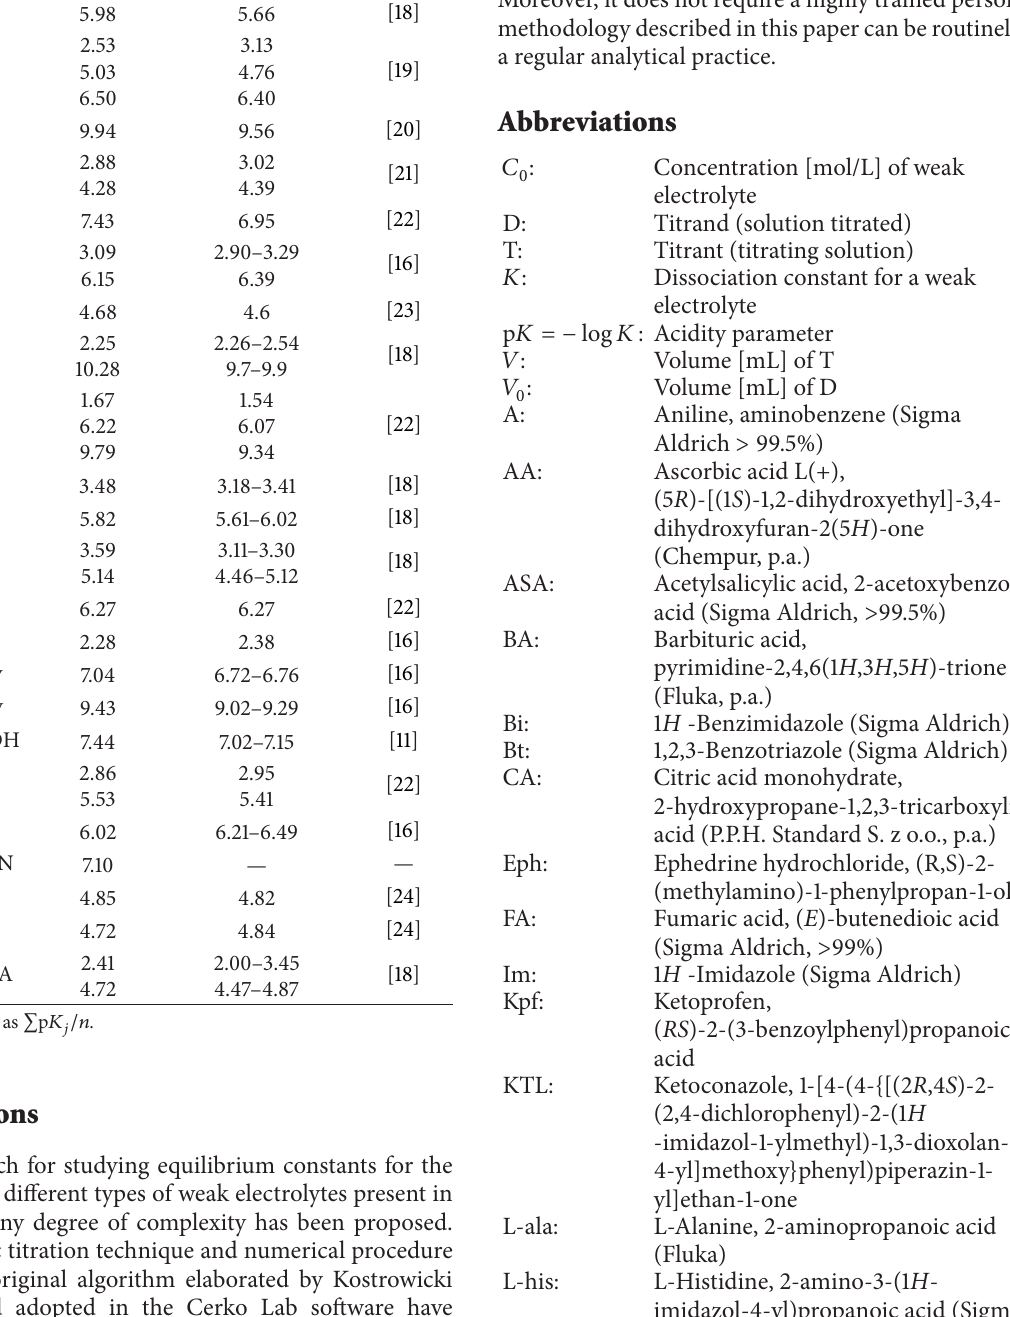
’svaluesofthecompounds a